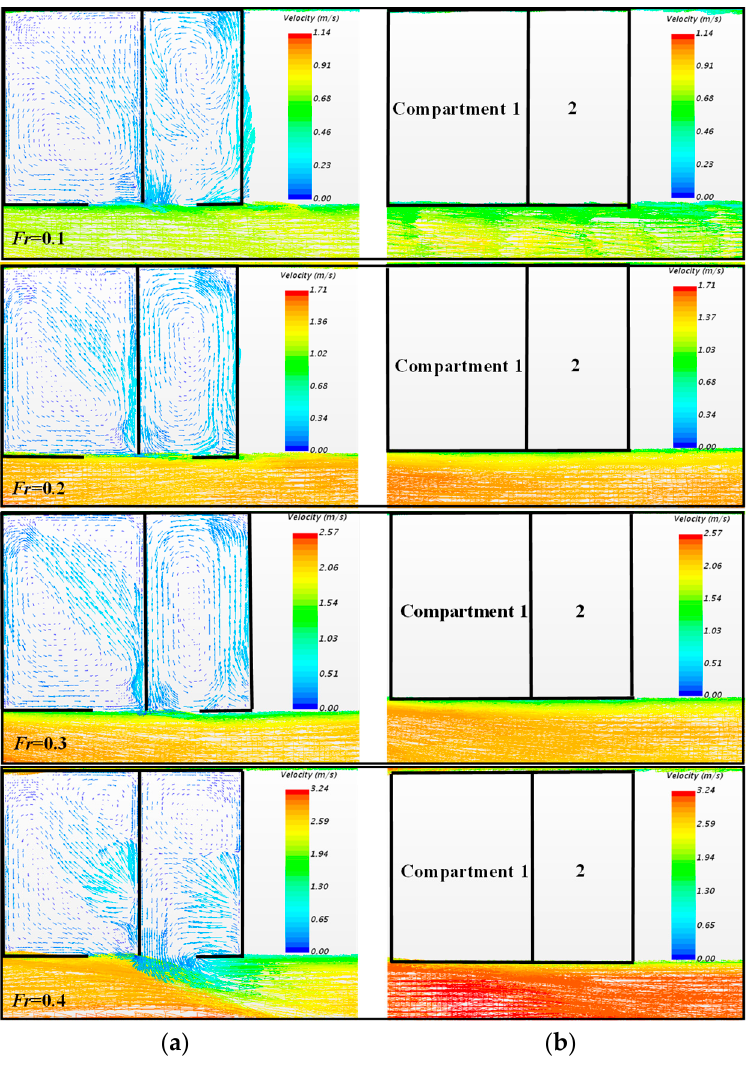
Figure 16. Comparison of local flow for two cases: ( a ) Symmetrical flooding case; ( b ) Damage-repaired case.